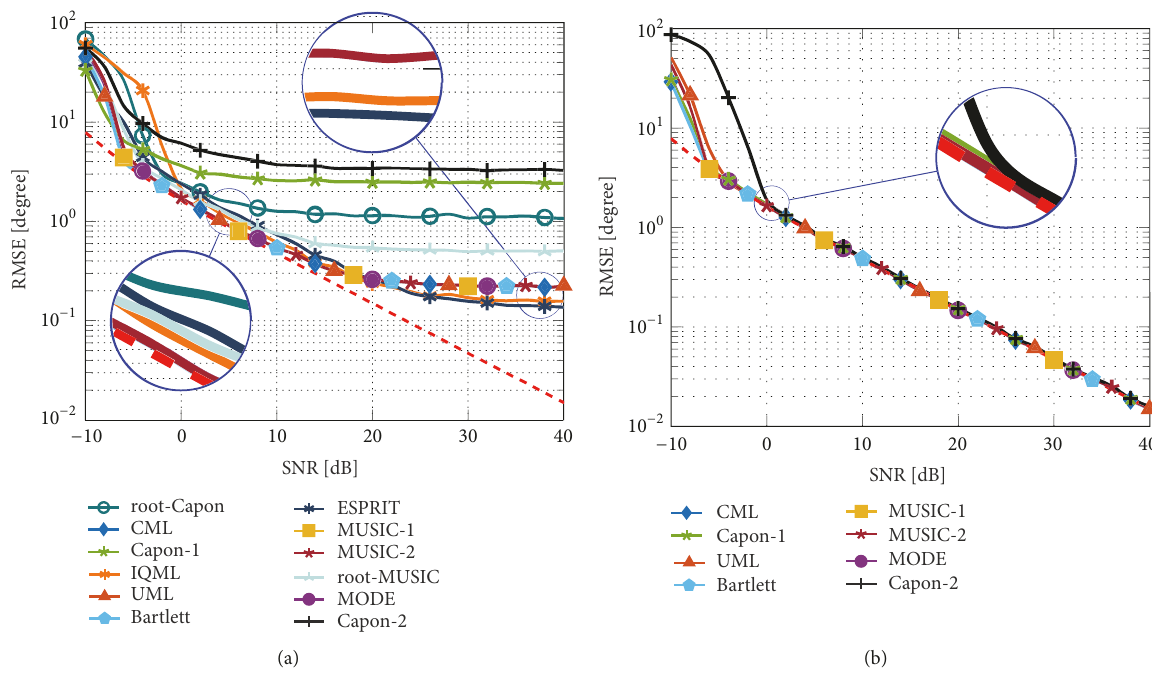
Figure 7: RMSE of AoA estimation with several DF techniques for (a) global calibration using the method of Sommerkorn to estimate the calibration matrix and (b) local calibration using the EADF as array model. The CRLB is plotted as red dashed line.